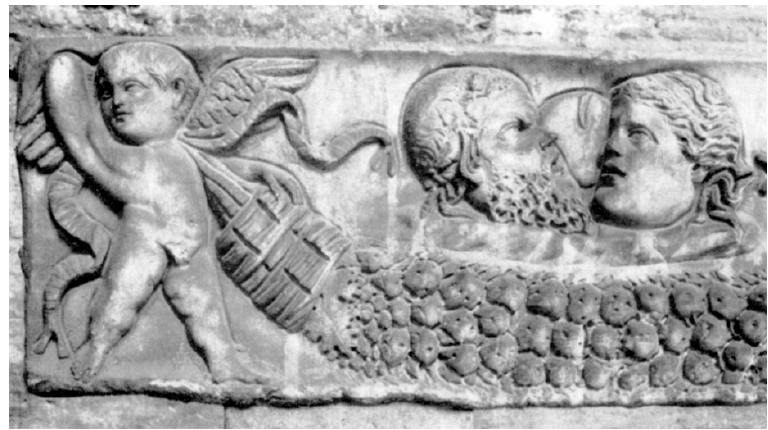
Figure 3. Sarcophagus with rose garland. Later third century CE. Rome, Terme di Diocleziano National Museum Inv. 124706. (Modified by author, after Honroth 1971, Taf. 12.2).